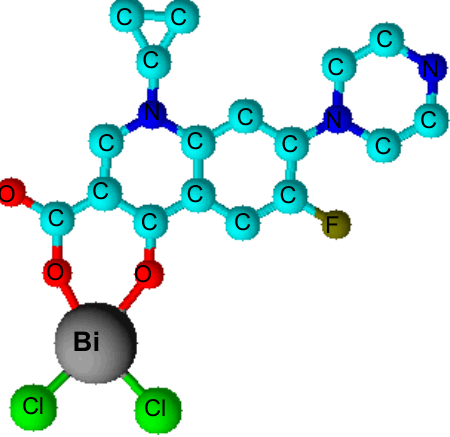
Figure 3. Suggested three-dimensional (3D)-structure for ciprofloxacin-bismuth